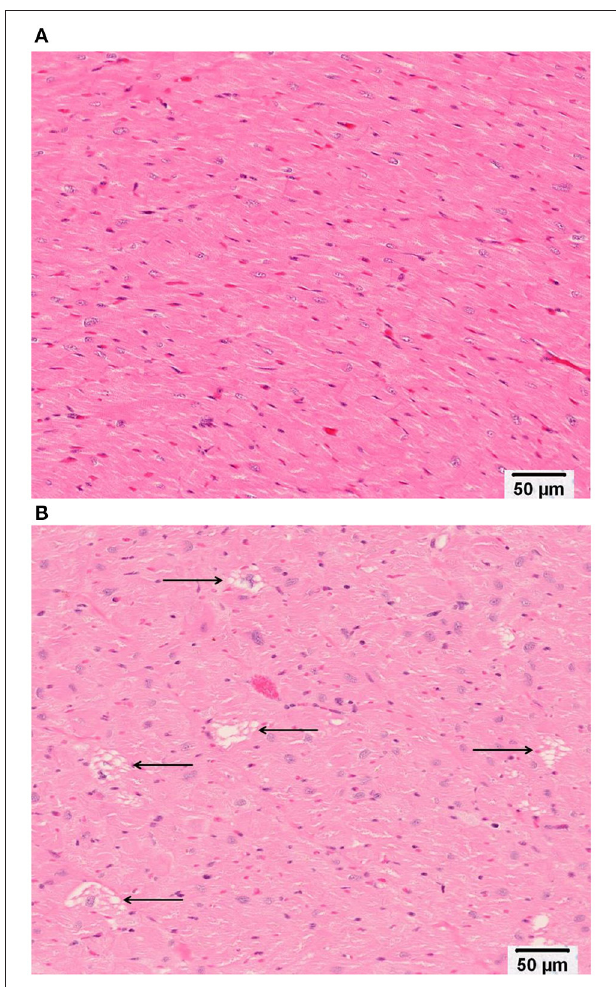
FIGURE 9 | Representative photomicrographs of heart tissue from (A) a Vehicle treated animal with normal myocardium; and (B) Doxorubicin treated animals with multifocal, cytoplasmic vacuolar degeneration of cardiomyocytes (arrows). Bar equals 50